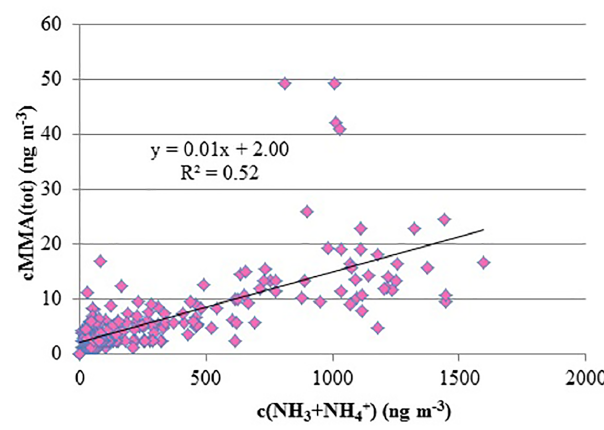
Figure 2. Concentrations (ngm − 3 ) of total MMA vs. concentra- tions of NH 3 + NH + in March and April 4